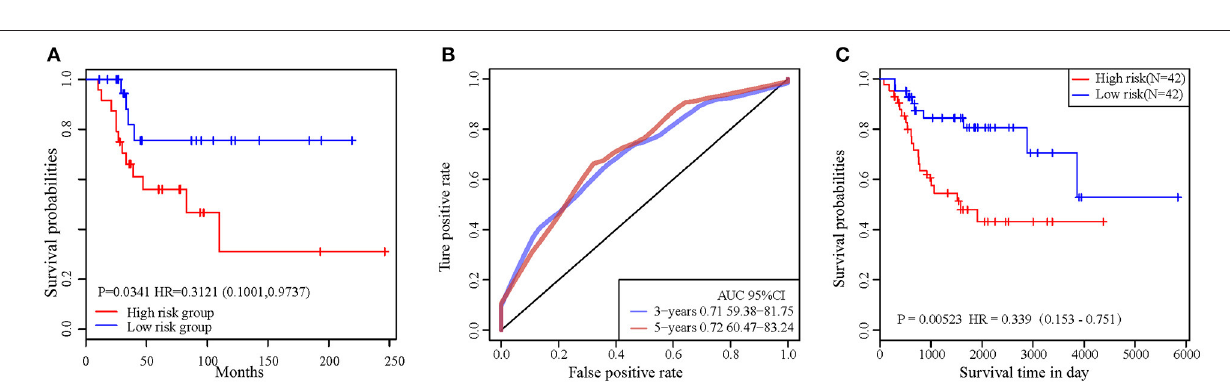
were significant prognostic differences between the 2 groups in TARGET dataset (log-rank test p = 0.00523). The result above indicated two-gene signature were capable of influence OSA